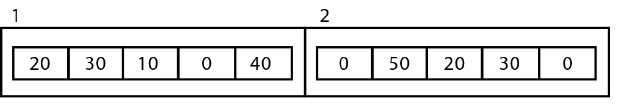
Figure 2. Example of a solution representation for a problem with five subgroups, two periods, and 100 vaccines per period.